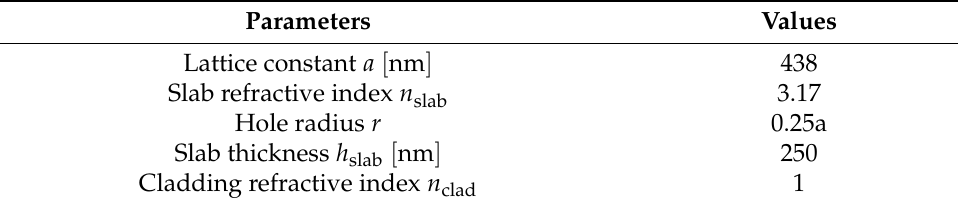
Table 1. Simulation parameters of the line-defect waveguide assumed throughout Section